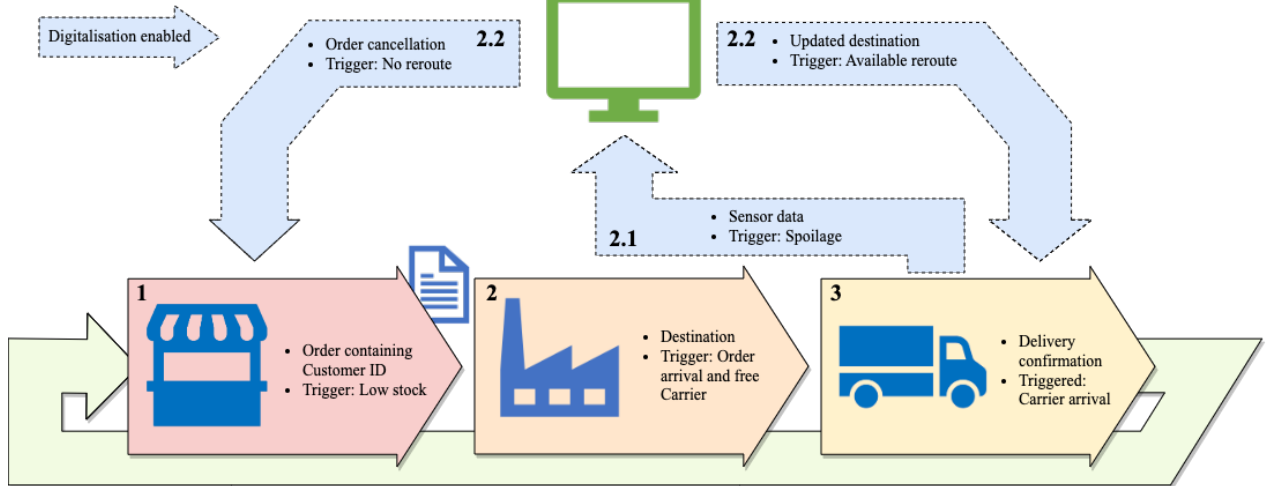
Figure 3. A Communication between agents during simulation. The numbers represent the order of communications in the simulation. 2.1 and 2.2 do not always occur, only when spoilage is detected. There are two variations of step 2.2 as they cannot simultaneously